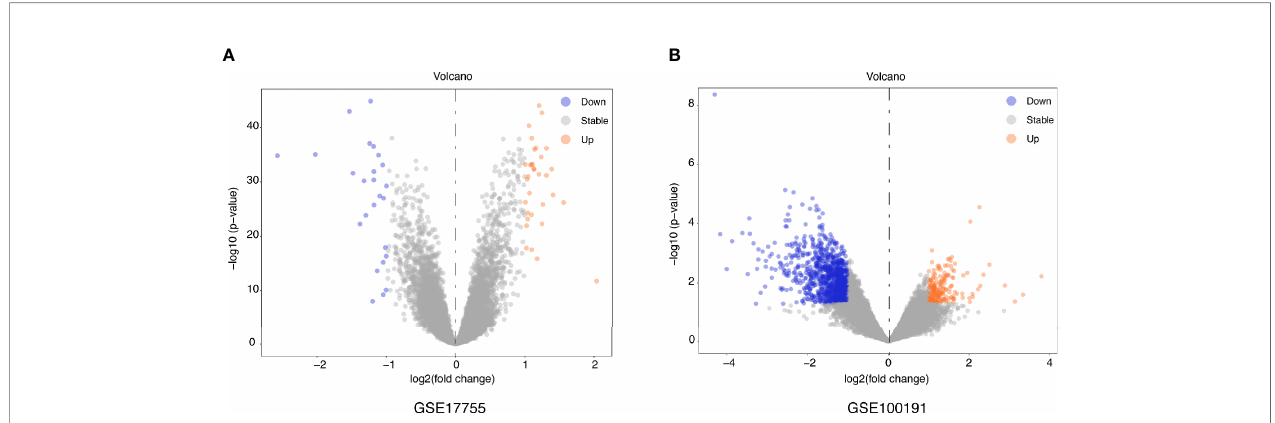
FIGURE 2 | Volcano plots of DEGs distribution in GSE17755 (A) and GSE100191 (B) . Orange represented a high expression of robust DEG, while blue represented a low expression of robust